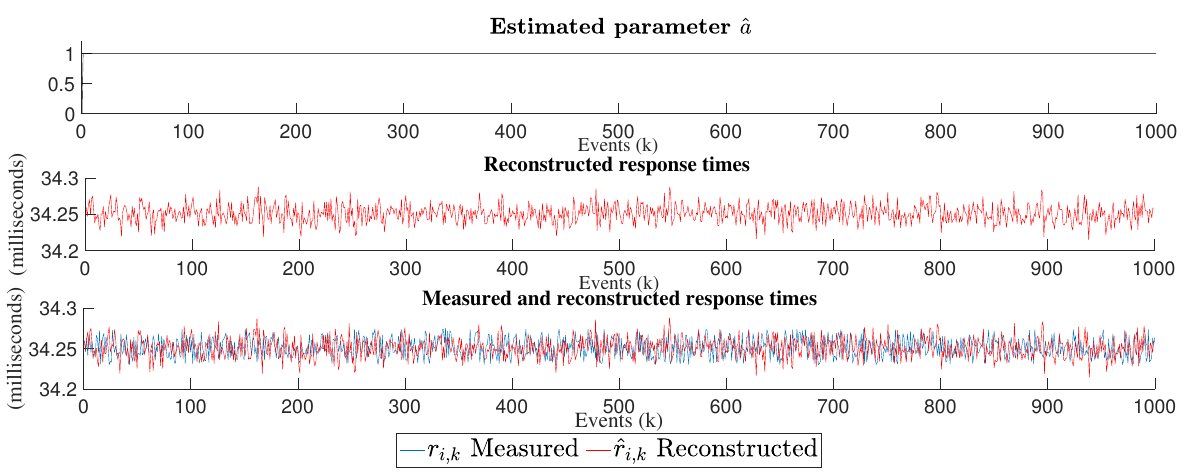
Figure 8. Estimated parameter ˆ a graph, reconstructed response times ˆ r i , k and comparative graph of measured response times r i , k vs. reconstructed response times ˆ r i , k for the 32 × 32 matrix inversion experiment.